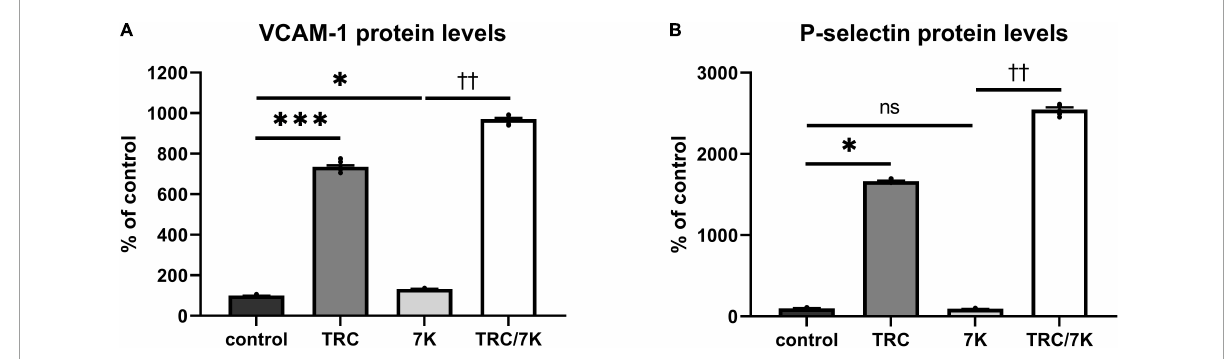
FIGURE4 Effect of TRC105 on 7K-induced protein levels of cell adhesion molecules in HAoECs. (A) VCAM-1 protein levels; (B) P-selectin protein levels. For the detailed experimental design, please see Figure 1 . The data are presented as mean ± S.E.M ( n = 6). ns, p ≥ 0.05; * p < 0.05; *** p < 0.001, using Kruskal–Wallis test for comparisons among control, TRC and 7K, and †† p < 0.01, using Mann–Whitney test for comparison between 7K vs . TRC/7K.